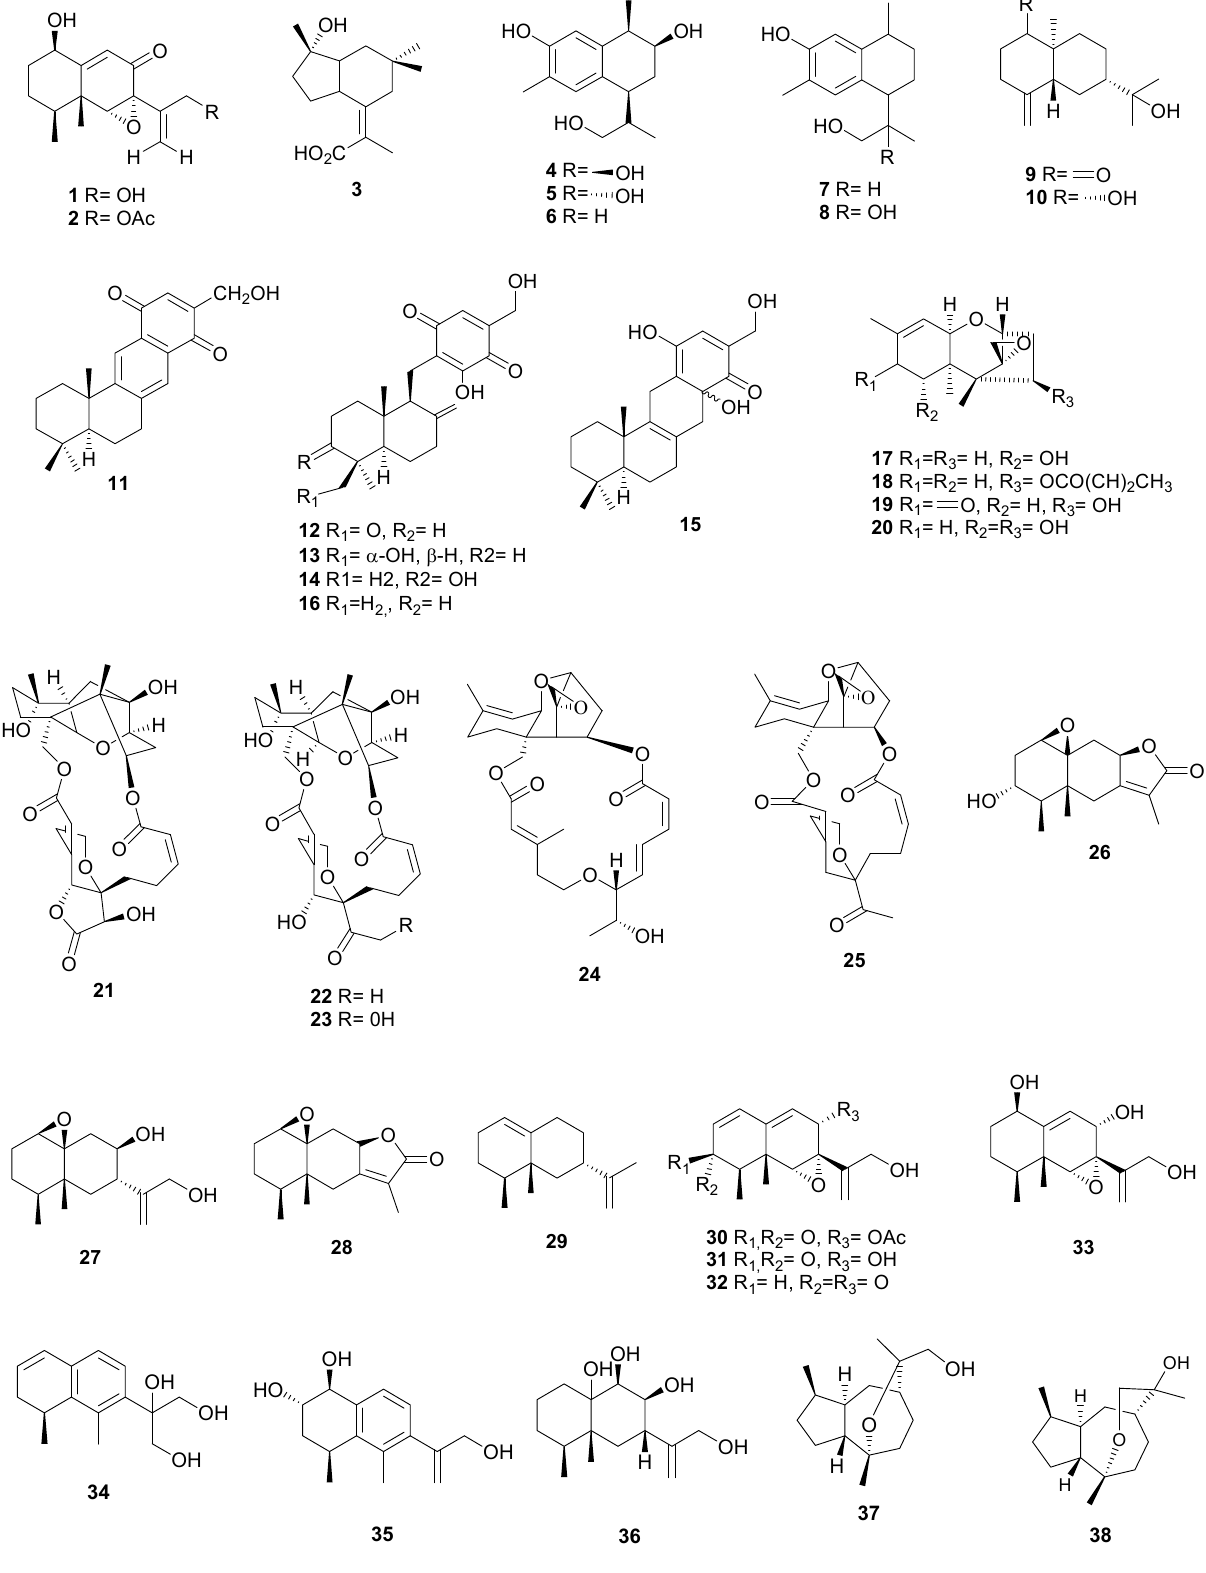
Figure 1. Chemical structures of sesquiterpenes from endophytic